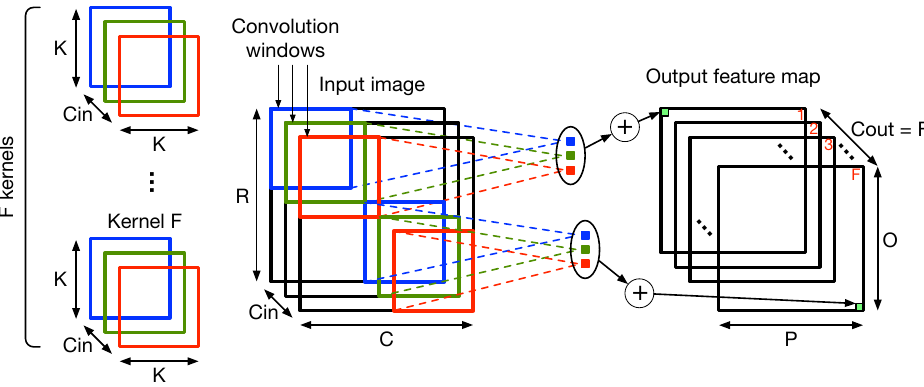
Figure 6. High-dimensional convolution operation.